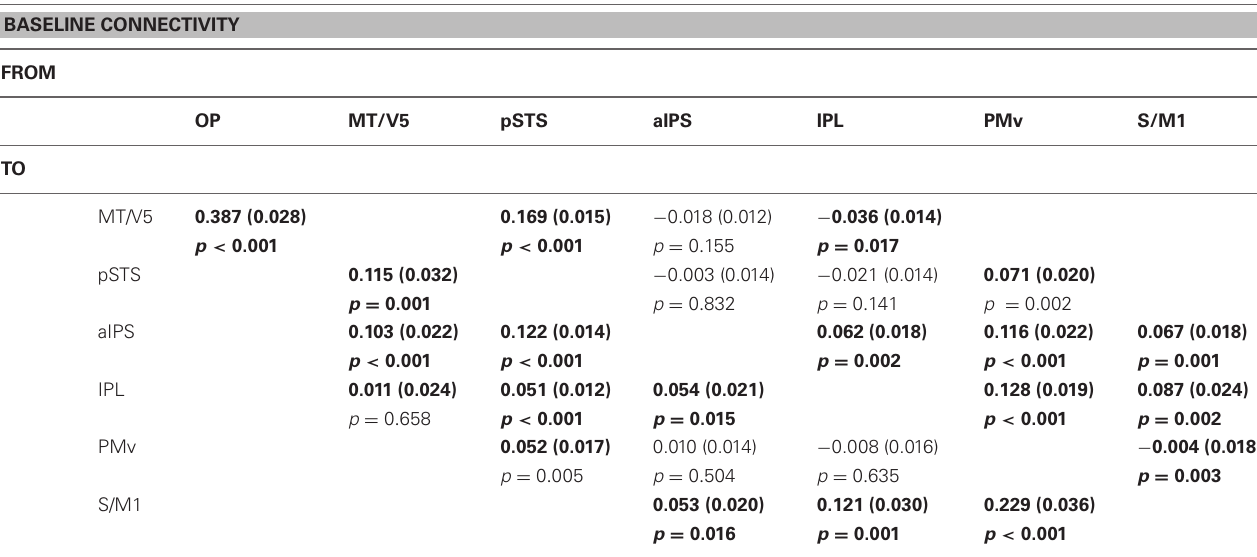
Table 7 | Results of one-sample t -test for coupling parameters of baseline connectivity. BASELINE CONNECTIVITY